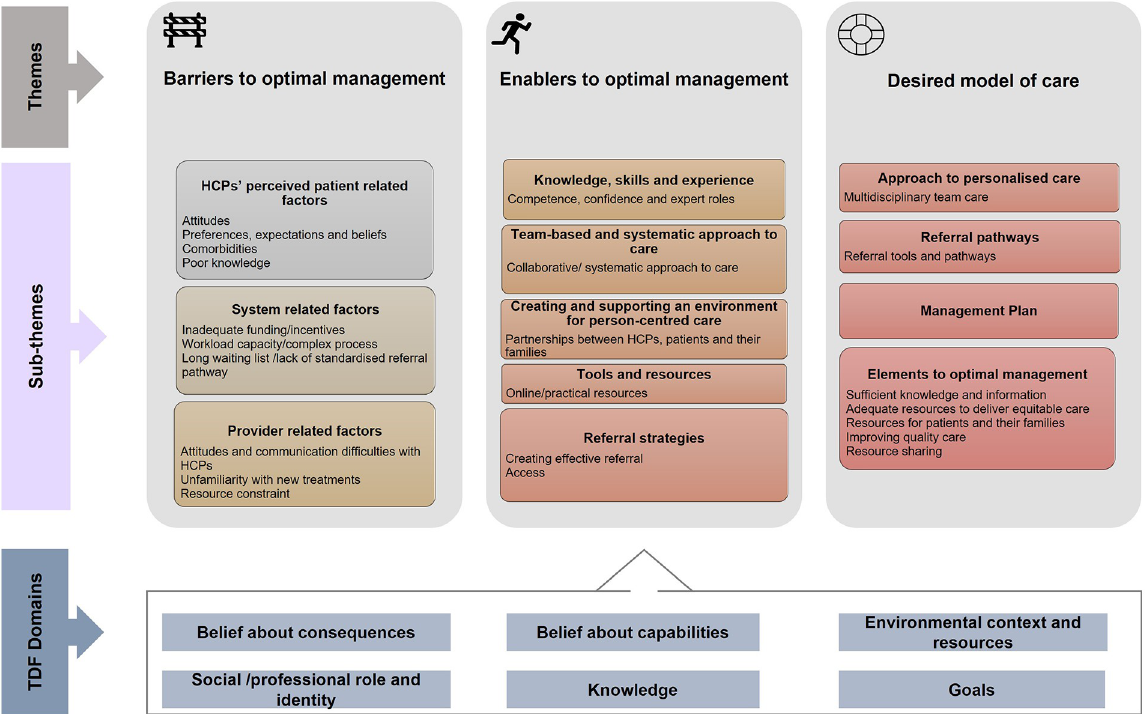
Fig 2. Emerging themes and sub-themes identified, and predominant TDF domains. HCP = healthcare professional. TDF = Theoretical Domains Framework.